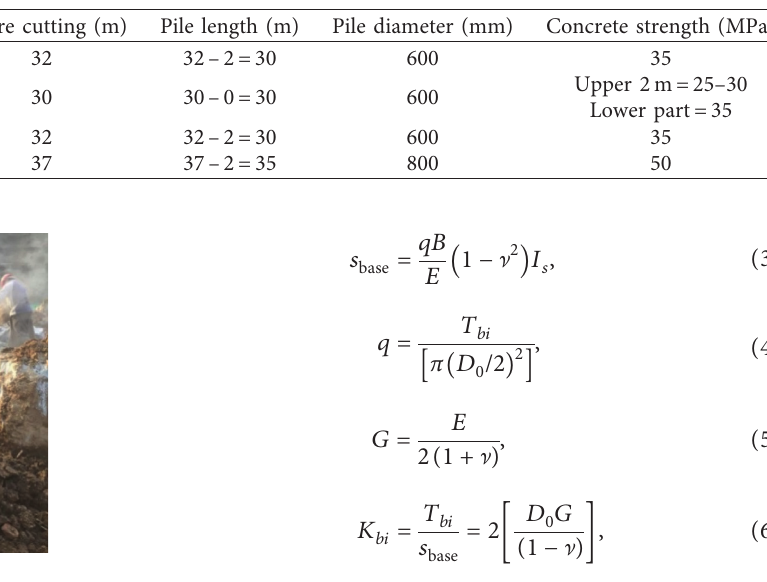
Table 1: Information of tested piles.